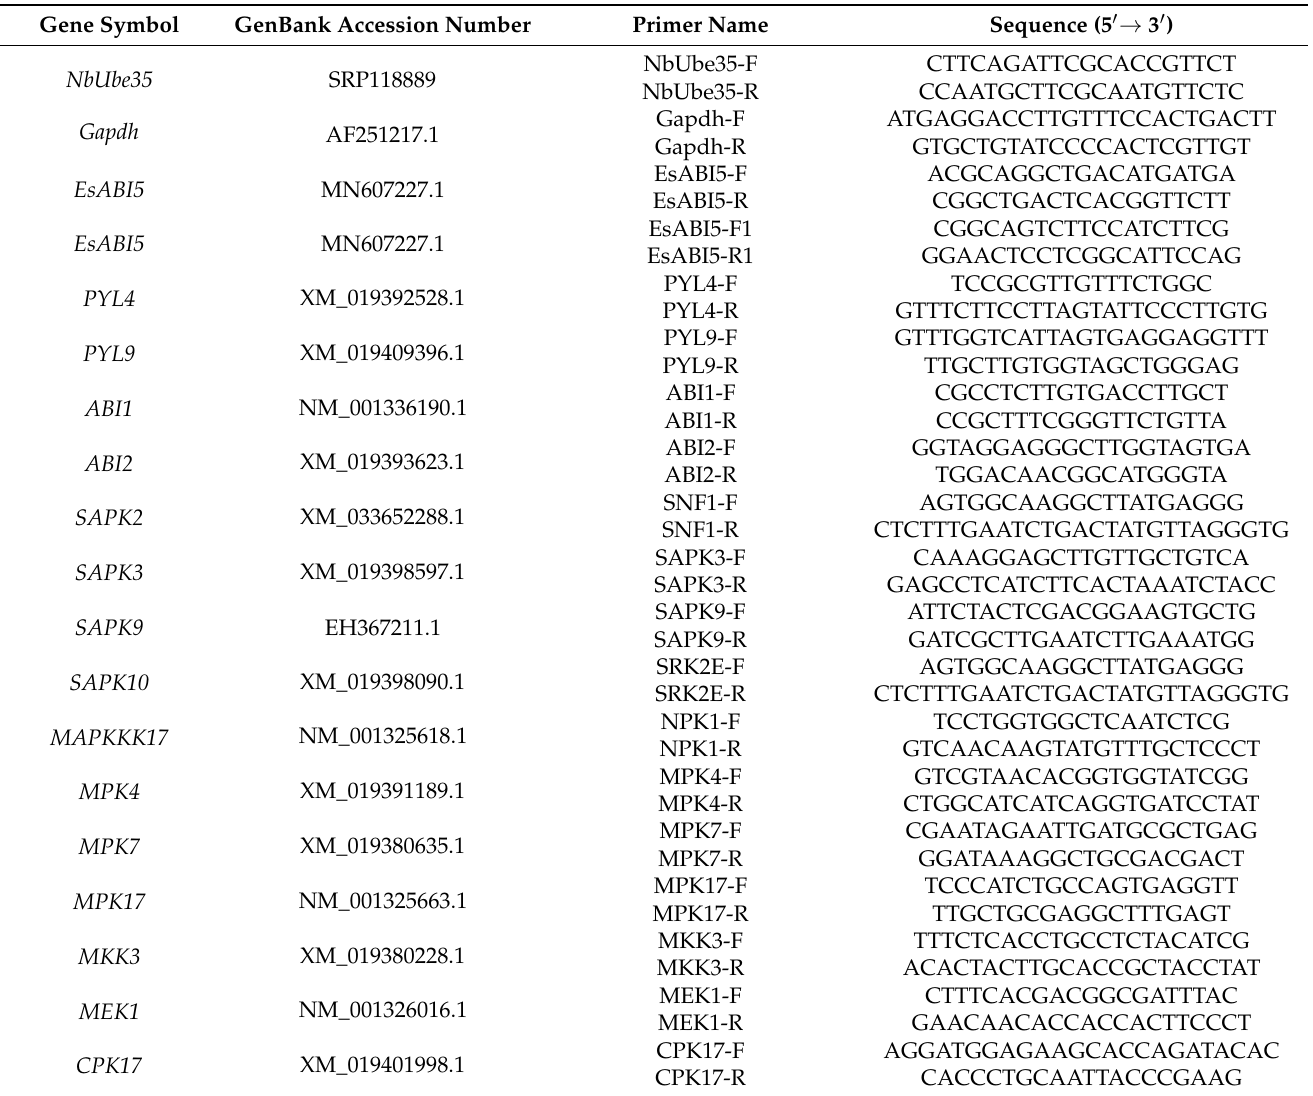
Table 3. Primer sequences used for